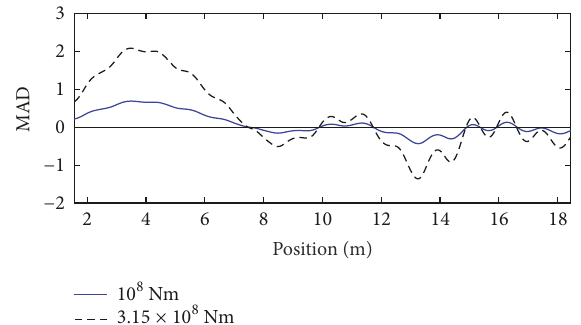
Figure 11: Effect of a rotational spring applied to the left support of a simply supported